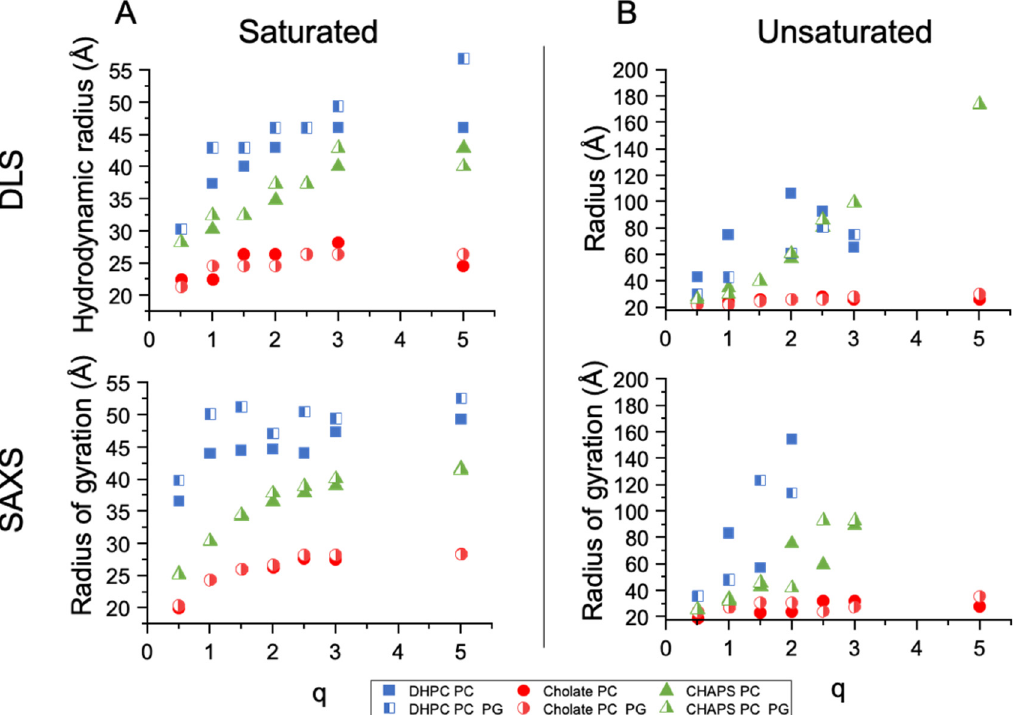
Figure 2. DLS (top)- and SAXS (bottom)-derived radii of bicelles for ( A ) DMPC and DMPC:DMPG 80:20 and ( B ) POPC and POPC:POPG 80:20 mol%. Data were measured at 25 °C in tris-buffered saline (TBS). The radius of gyration could not be estimated for unsaturated lipids mixed with CHAPS at q = 5 and unsaturated lipids mixed with DHPC at q values of 2.5, 3, and 5 due to the absence of the Guinier regime. The DLS curves are representative of one to three independent experiments. Most of the SAXS data were measured in duplicate.